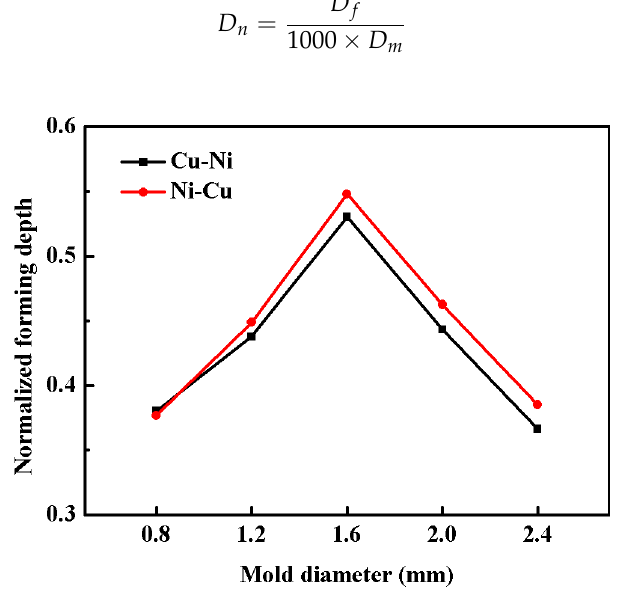
Figure 9. Feature size effect on normalized forming depth (laser energy was 1800 mJ).